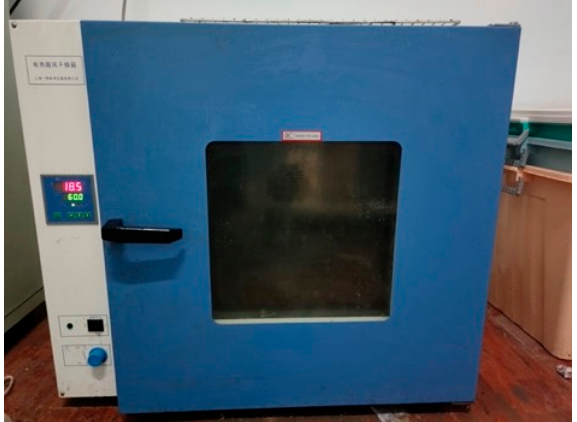
Figure 4. The specimens drying in the oven.